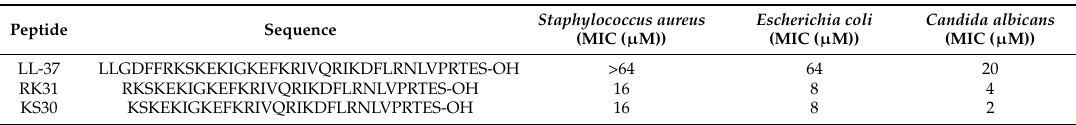
Table 1. Reported microbial inhibitory concentration (MIC) of different antimicrobial peptides sequences from LL-37 (adapted from Gallo and Murakami